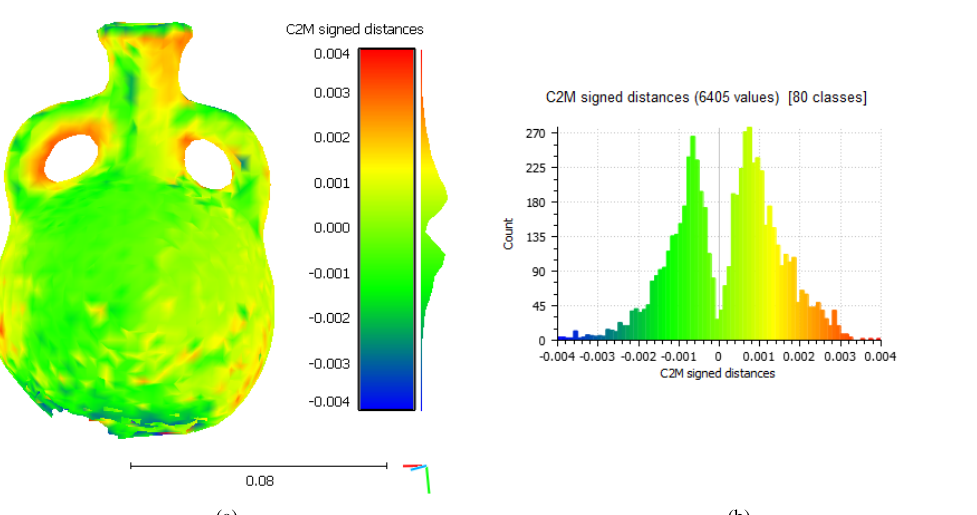
Figure 3: (a) Distances between the points of the Structure Sensor model and the mesh of the high resolution photogrammetric model; (b) related histogram.